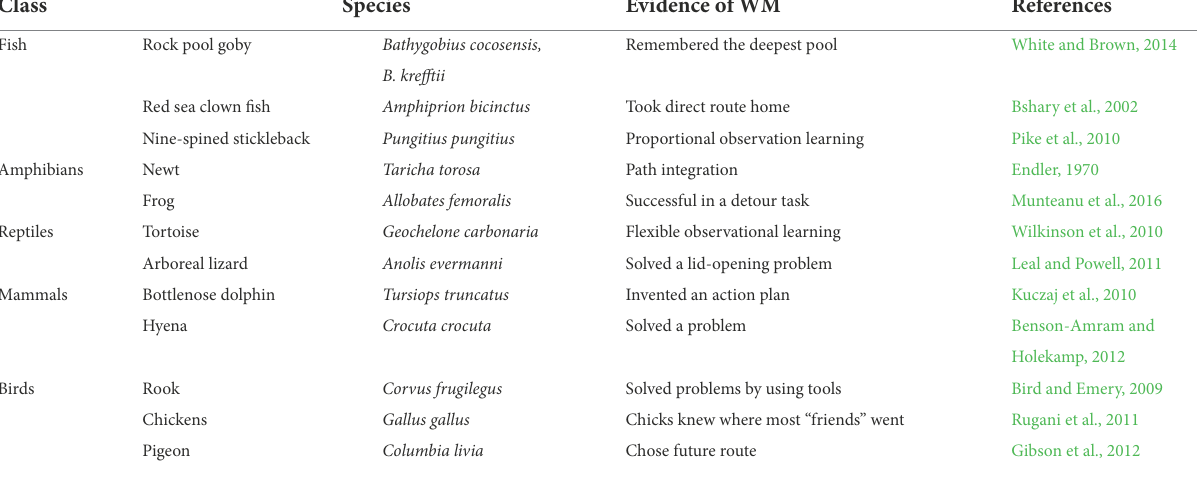
TABLE 1 WM in five vertebrate